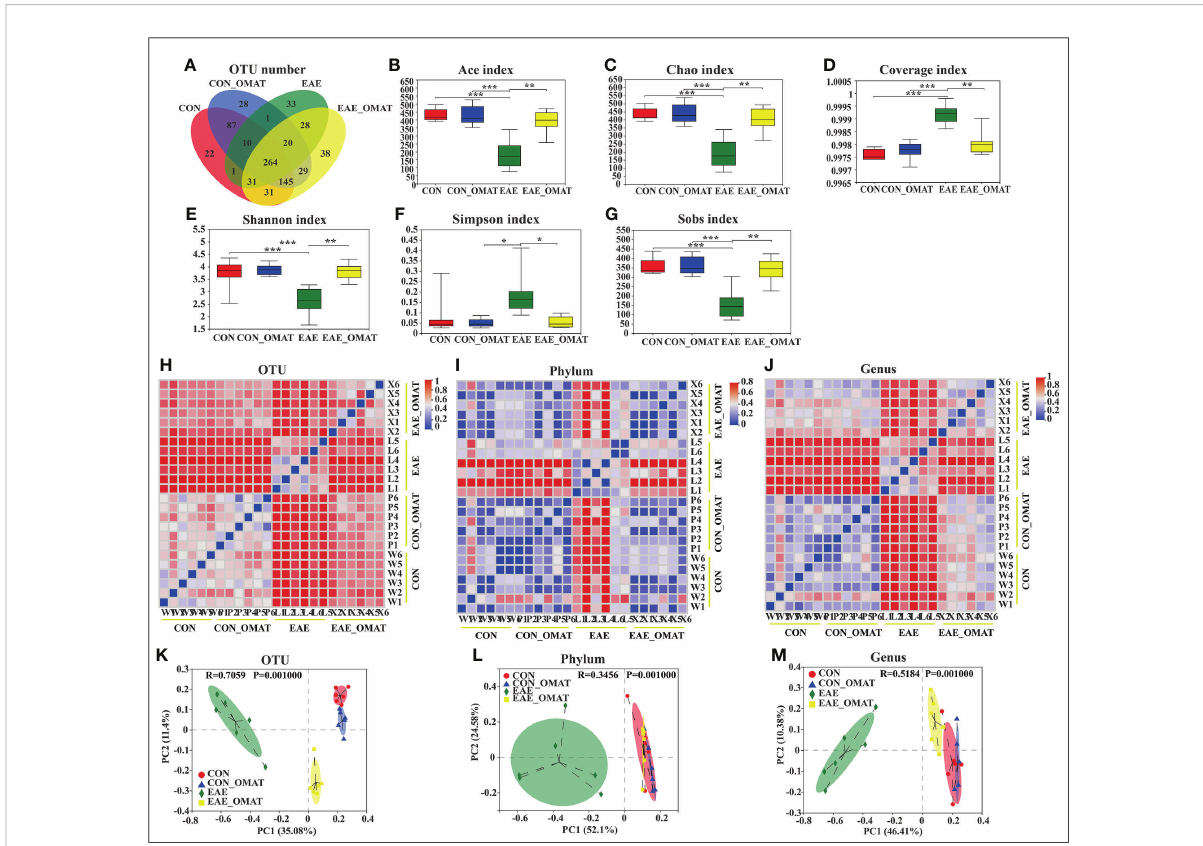
FIGURE 2 Gut microbiota alpha- and beta-diversities in the four mice groups (n = 6 in each group). (A – D) Alpha-diversity indices. (A) The number of species and (B) Ace-estimated OTUs, (C) the Chao index value (D) the Coverage index value (E) the Shannon index value (F) the Simpson index value, and (G) the Sobs index value of fecal microbiota from the four groups based on 16S rRNA analysis. Each box plot represents the median, interquartile range, minimum, and maximum values. (H – M) Beta-diversity indices. Sample-distance heatmap based on weighted UniFrac analysis at the level of OTUs (H) , phylum (I) , and genus (J) . Principal coordinates analysis (PCoA) was used to study the similarity or difference of the microbial community composition at the level of OTUs (K) , phylum (L) , and genus (M) . Data are expressed as the mean ± SD and statistical differences are represented by *, P < 0.05; **, P < 0.01; ***, P < 0.001 based on the Wilcoxon rank-sum test with the Benjamini – Hochberg method for multiple group